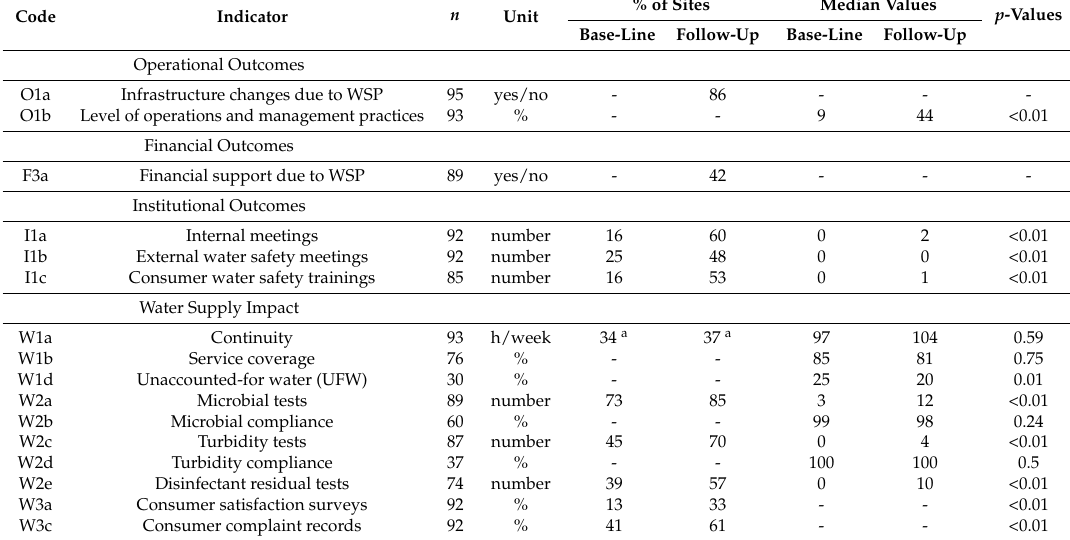
Table 3. Comparisons of WSP outcome and impact indicators between baseline and follow-up. The analysis includes the number of sites ( n ), the percentage of sites reporting any given activity, median values across all sites at baseline and follow-up, and the statistical significance of the change between baseline and follow-up ( p -value). p -values were determined using the paired Wilcox rank-sum test for all except the binary W3a and W3c indicators, which were determined using the chi-squared test. Results for each indicator, except O1b, are reported for 12-month periods.